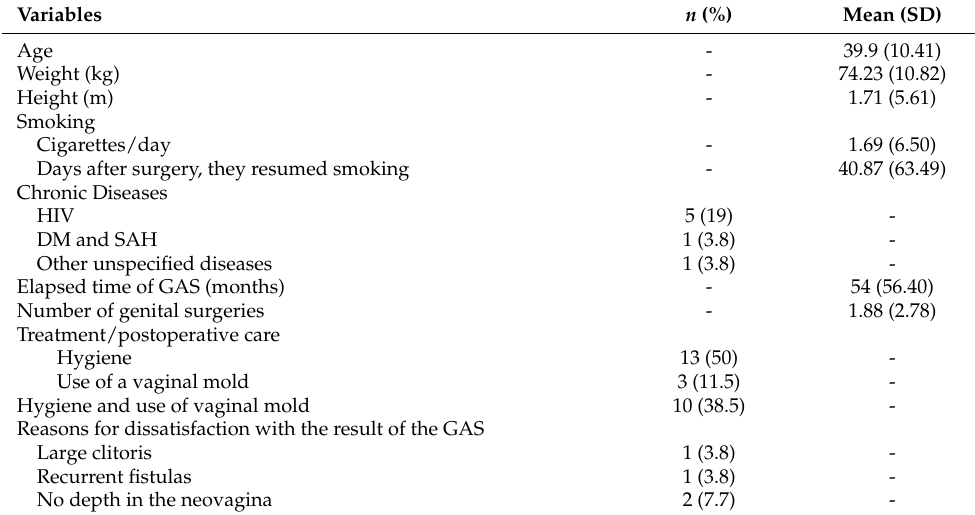
Table 1. Sample characteristics.